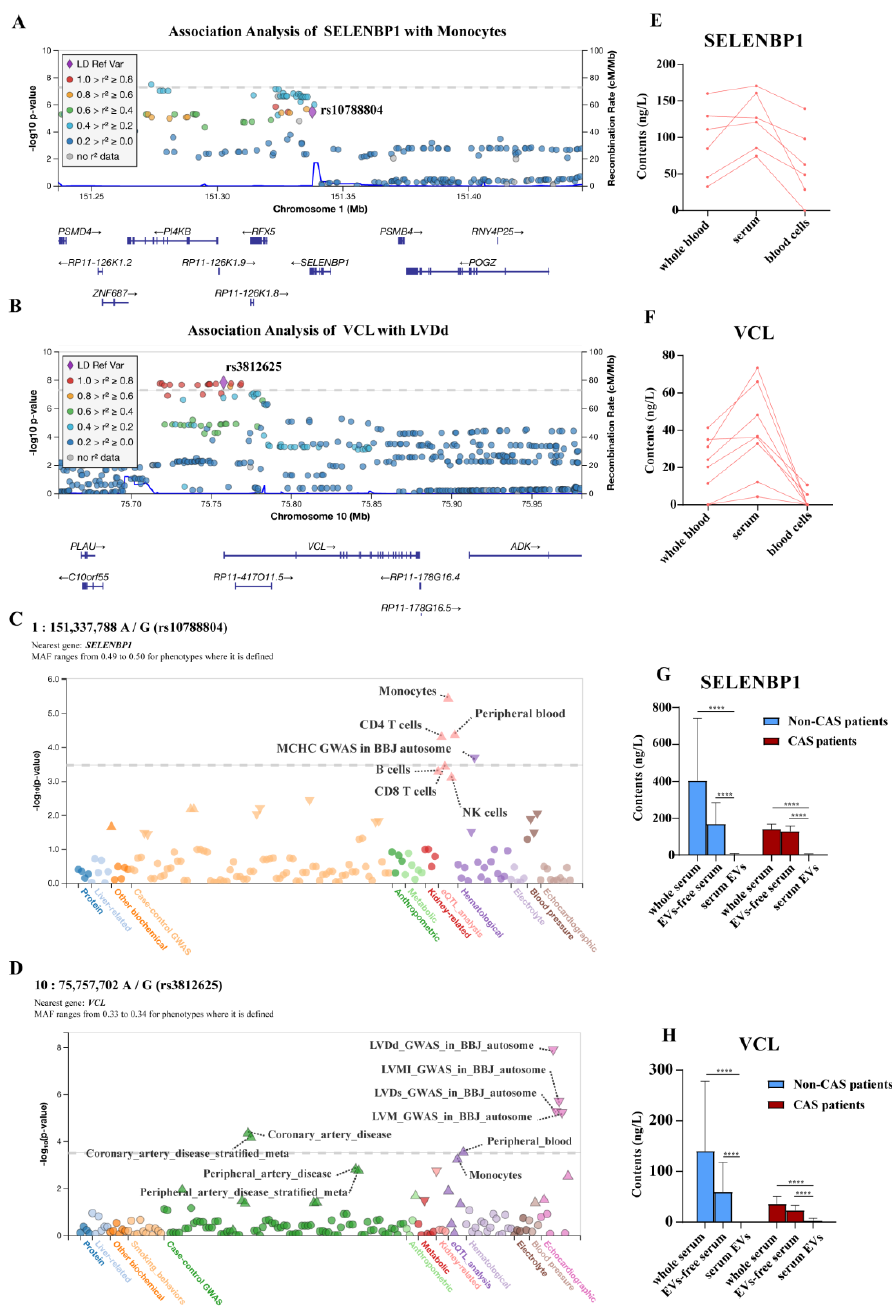
Figure 4. SELENBP1 and VCL were associated with coronary artery diseases and were abundantly distributed in extracellular vesicles (EVs)-free serum. ( A ) Genome-wide association study (GWAS) of SELENBP1 sequence variants with monocyte aggregates. The common single nucleotide poly- morphism (SNP) rs10788804, that was significantly associated with monocyte aggregates in hu- mans, is indicated by a purple dot. ( B ) GWAS of VCL sequence variants with cardiac contractility. The common SNP rs3812625 that significantly associated with the left ventricle dimension at the diastole (LVDd) in humans is indicated by a purple dot. ( C , D ) Phenome-wide association studies (PheWAS) of the SELENBP1 SNP rs10788804 and VCL SNP rs3812625 with coronary artery diseases. ( E , F ) Enzyme-linked immunosorbent assay (ELISA) detection of SELENBP1 and VCL in whole blood, serum, and blood cells. n = 6 for each group. ( G , H ) ELISA detection of SELENBP1 and VCL in whole serum, EVs-free serum, and serum EVs samples. n = 21 for non-CAS group and n = 25 for CAS group. ****, p < 0.0001 as